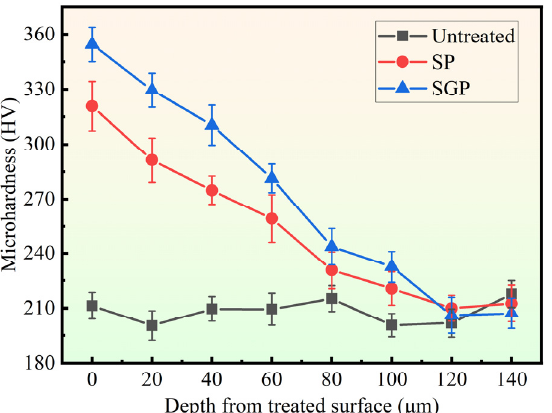
Figure 6. The microhardness distribution in the depth direction of the untreated, SP, and SGP sam- ples.